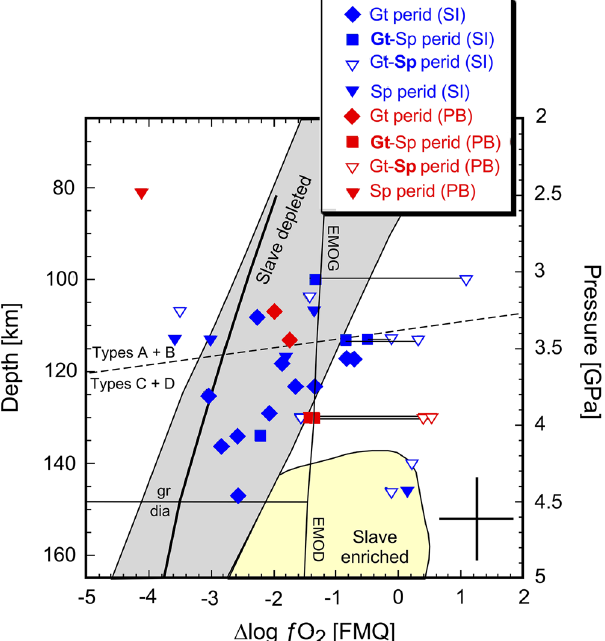
Figure 4. Variation in ∆logƒO 2 as a function of pressure/depth for samples from this study. Pressure was converted to depth assuming Depth (km) = P (GPa)*32.4. Thin horizontal lines connect ƒO 2 values determined from garnet (solid) and spinel (open) equilibria from the same garnet-spinel peridotite xenolith. The dashed line demarcates the occurrences of type A and B garnets with respect to those with type C and D signatures. The grey and yellow fields encompass the depleted and enriched samples reported for the Slave craton (Yaxley et al. 41 ; Creighton et al. 42 ). The thick solid line illustrates the predicted variation for pre-metasomatic (primitive) mantle peridotite along a 40 mW/m 2 geotherm from Luth and Stachel 38 . The position of the graphite-diamond (gr-dia) transition was adopted from Kennedy and Kennedy 43 . EMOG and EMOD represent the positions of equilibria controlling carbonate stability in harzburgitic bulk compositions: enstatite + magnesite = forsterite + graphite (G) or diamond (D) + O 2 from Luth and Stachel 38 , computed for a 40 mW/m 2 geotherm. The black cross in the lower right hand corner illustrates the estimated uncertainties in the ƒO 2 and pressure